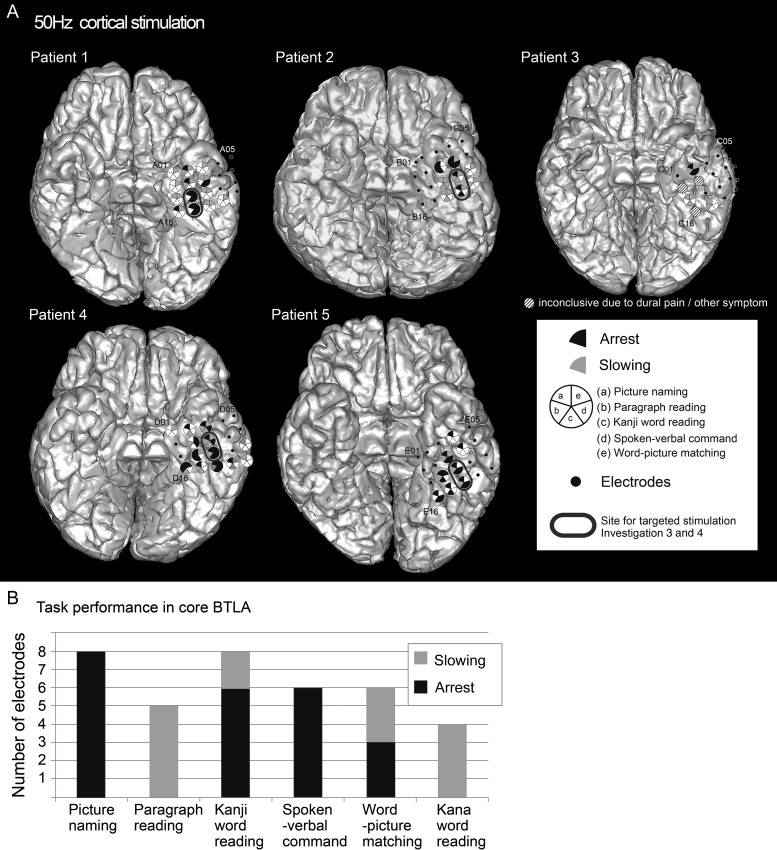
(A) The results of language mapping with conventional 50 Hz cortical stimulation of vATL sites in Patients 1–5. Small black dots represent subdural electrodes investigated with cortical stimulation. Electrodes showing any language impairment are illustrated with large circles with 5 segments (one for each task). Filled segments denote impairment of the corresponding task by stimulation. A black fill denotes arrest by stimulation and gray fill denotes slowing or errors. The gray ovals mark the core language electrodes used as the site for the targeted stimulation Investigations 3 and 4 in these 3 patients. In this target area, high-frequency stimulation generated impairments across all the semantically related tasks (both receptive and expressive), but spared kana word reading (which requires visual processing and speech production but not access to word meaning, unlike the other tasks), consistent with the conclusion that this region is crucial for pan-modal semantic processing. Clinical stimulation of vATL in Patients 3 and 6 was partial, inconclusive and had to be discontinued due to dural pain or other symptoms. For clarity, only the subdural grid (4 × 5 electrodes) in the basal temporal area is shown. (B) The performance status for each task during vATL stimulation (Patients 1, 2, 4, and 5). Picture naming, kanji word reading, and spoken verbal command task were consistently impaired upon stimulation while kana word reading was rarely impaired.